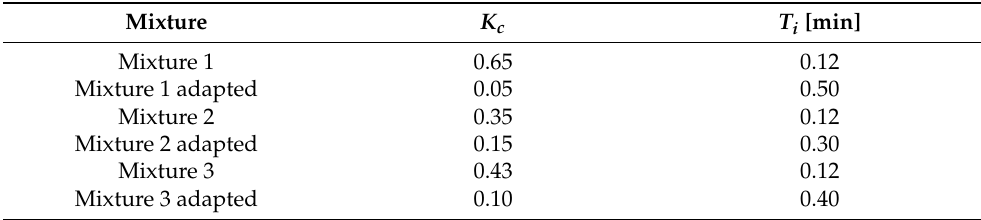
Table 11. Original and adapted tuning parameters for the re-recording of Scenarios 1 and 2 of all